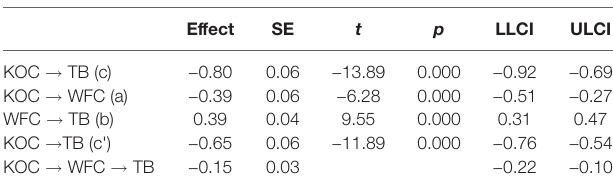
TABLE 3 | Mediating effect of WFC.